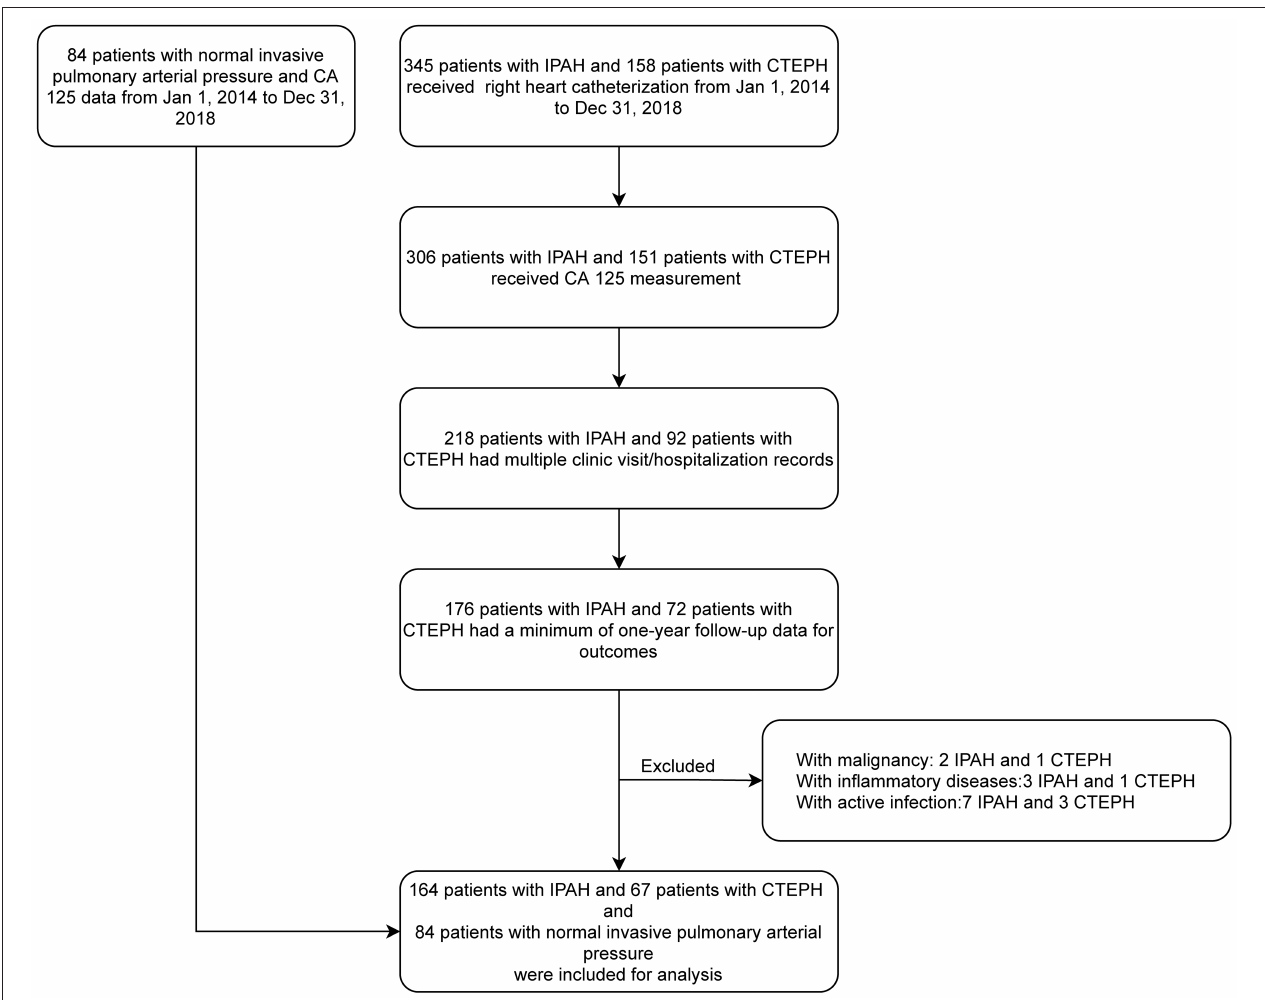
FIGURE 1 | Flow diagram of patient enrollment and exclusion. CA 125, Carbohydrate antigen 125; CTEPH, Chronic thromboembolic pulmonary hypertension; IPAH, Idiopathic pulmonary arterial